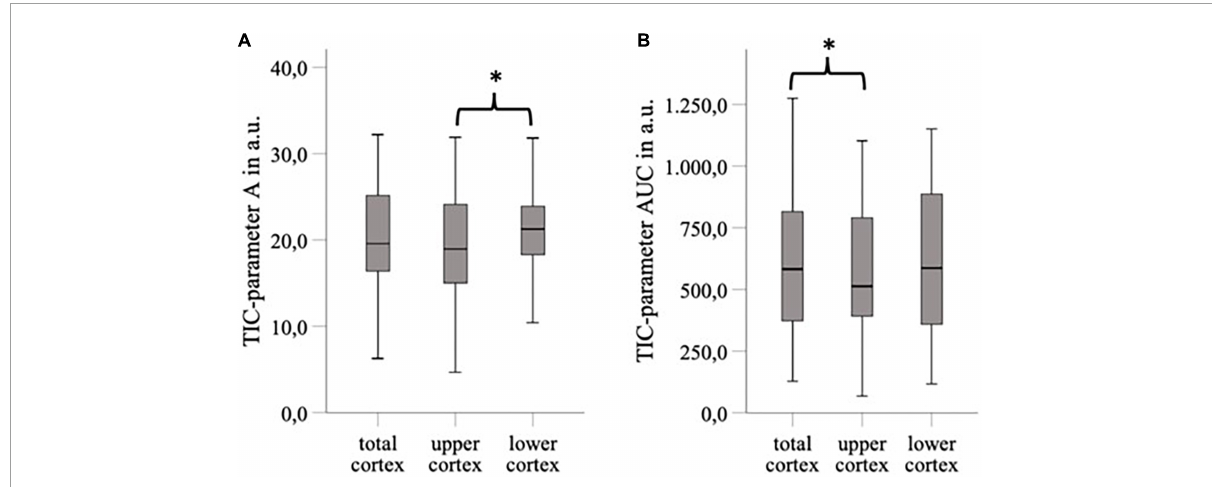
FIGURE3 The area of ROI “total cortex” was approximately twice as big as the area of ROI “upper/lower cortex,” and the ROI “lower cortex” and “total cortex” were placed on average 4.44 cm deeper than the “upper cortex” ( p < 0.05). For TIC parameter, A was a significant difference between “upper cortex” vs. “lower cortex” ( (cid:49) A = 2,15 a.u., p < 0.05) (A) and for TIC parameter AUC between “upper cortex” and “total cortex” ( (cid:49) AUC = 39,21 a.u., p < 0.05) (B) . ∗ p <